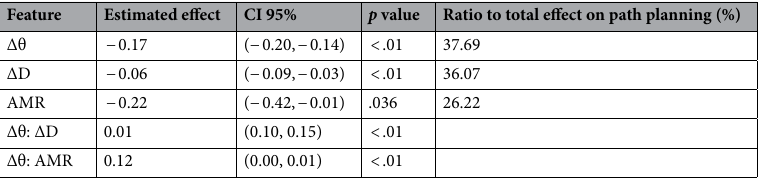
Table 3. Estimated effect, 95% confidence interval (CI), and ratio to total effect on path planning in the multivariate analysis with bootstrapping technique with random shuffling of 2000 surrogate